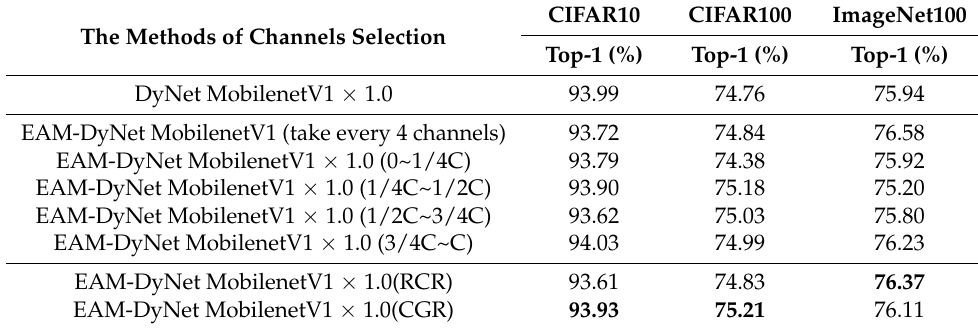
Table 4. The accuracy of standard static network, standard dynamic network, and EAM-DyNet in different channel selection methods on